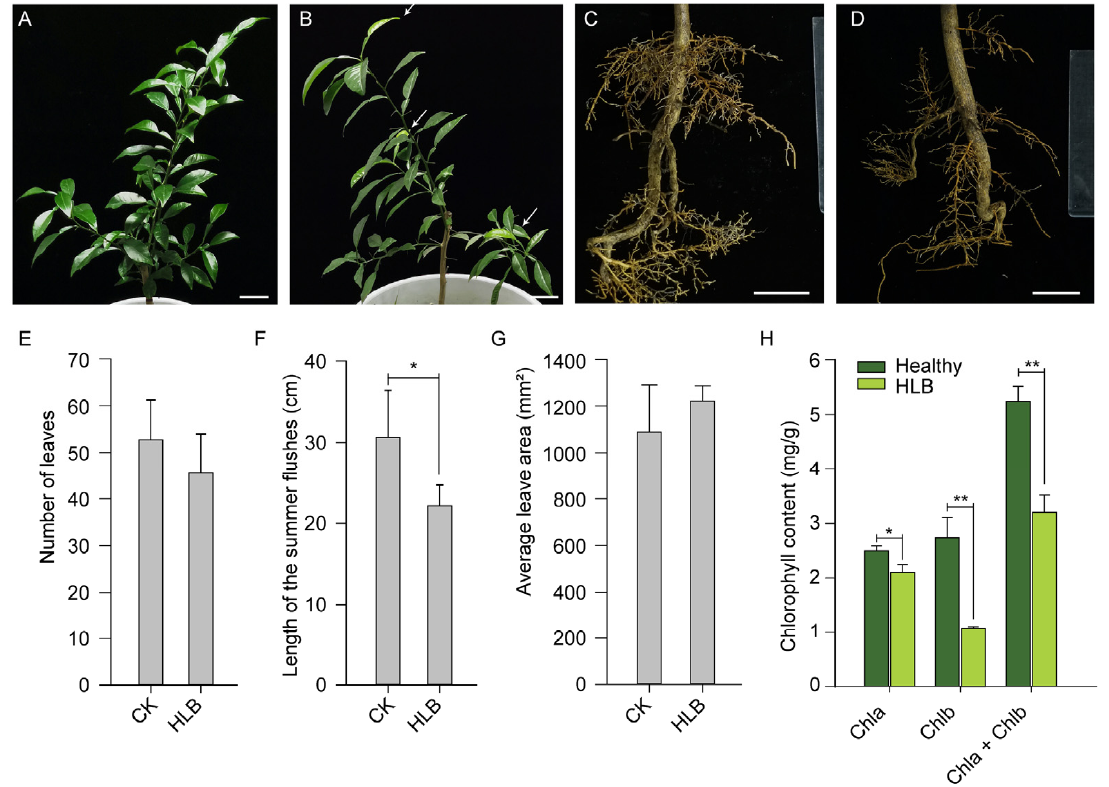
Figure 1. Growth impairment of Pujiang Xiangcheng due to CLas infection 15 weeks after inoculation. ( A ): The phenotypic appearance of the leaves and flushes in the mock-inoculated plants; ( B ): Growth status of the above ground part of C. junos positive for CLas; ( C ): The new growth of fibrous roots in the control plants; ( D ): The ruined root system in the HLB trees. The number of leaves ( E ); length of the summer flushes ( F ); average leaf area of the mature leaves ( G ); and the chlorophyll content of the leaves ( H ) were compared. Statistical analysis was completed by using a Student’s t test, significances were labeled as * ( p < 0.05) and ** ( p < 0.01). The white scale bar in ( A – D ) is 5 cm. The bar plots